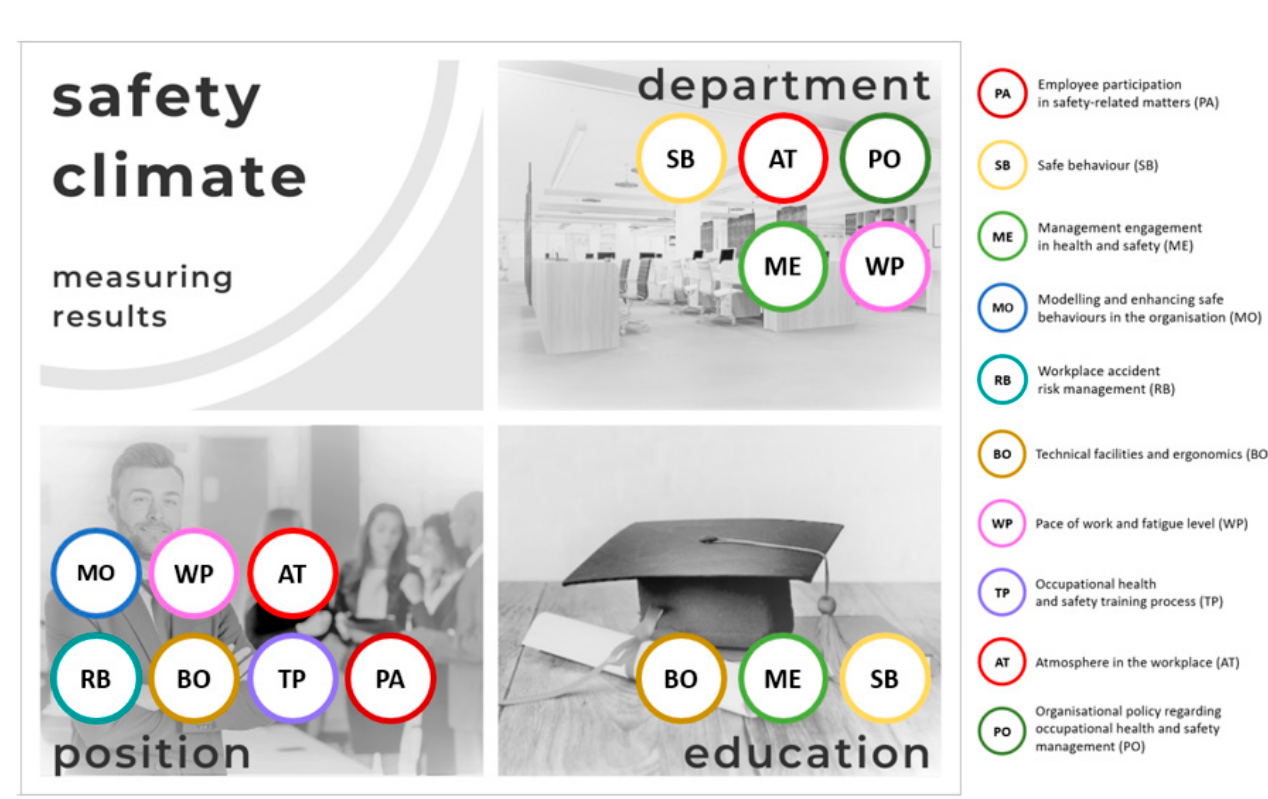
Figure 3. Statistically significant differences in the perception of safety culture dimensions broken down by social factors. Explanation: The dimensions of safety culture were assigned to individual social factors for which statistically significant results were obtained, confirmed subsequently by post hoc tests. Source: own elaboration based on the results of empirical research carried out in an international manufacturing company, n = 203.